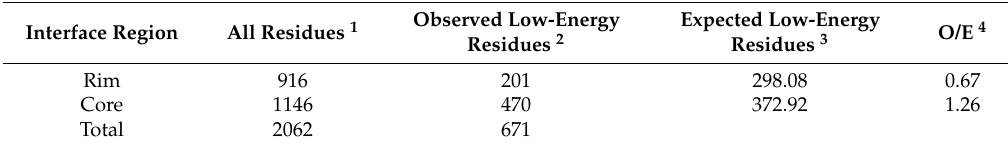
Table 2. Distribution of all interface residues and those energetically relevant for the